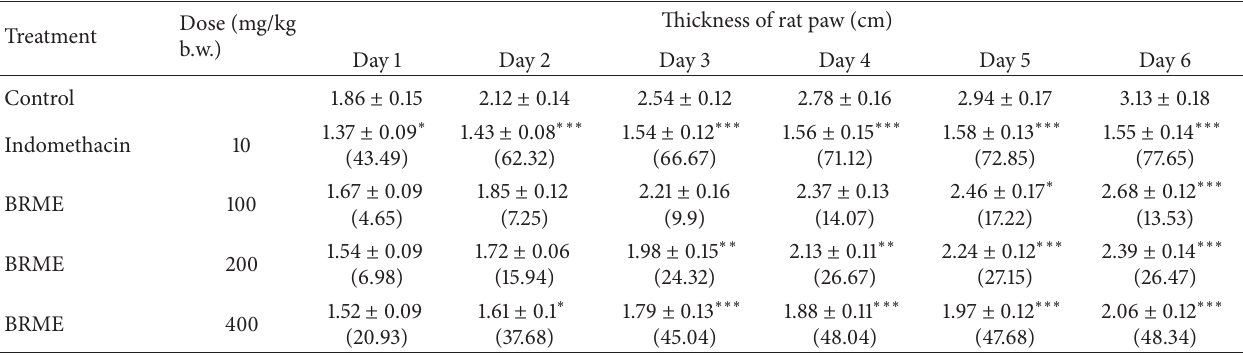
Table 5: Effect of methanolic extract of fruit of Bridelia retusa on formalin-induced paw oedema. Dose Treatment